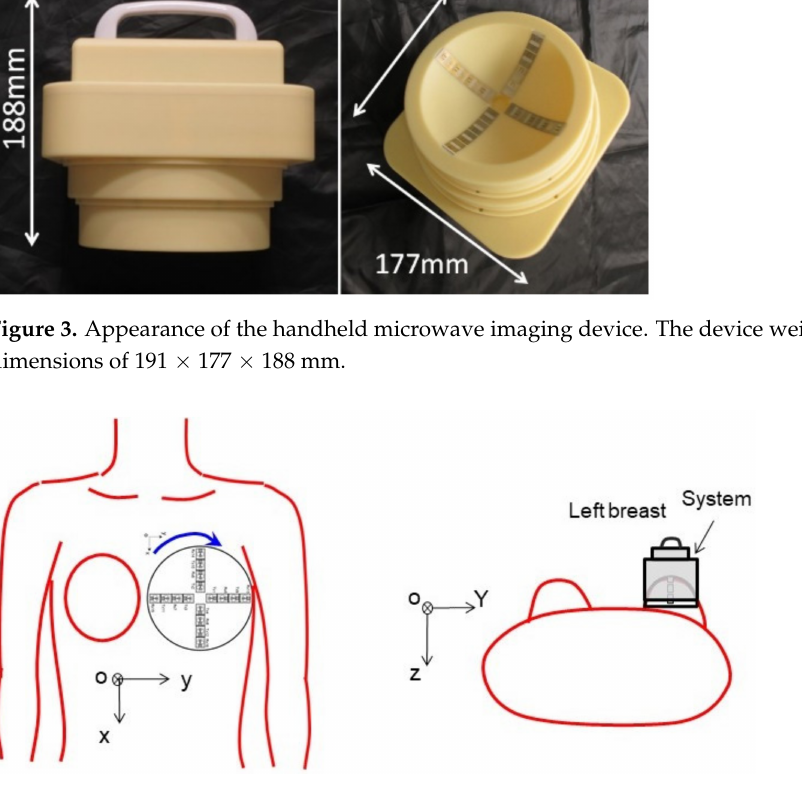
Figure 4. Positional relationship between the microwave imaging device and the patient. The detector is designed to be placed on the breast with the patient in the supine